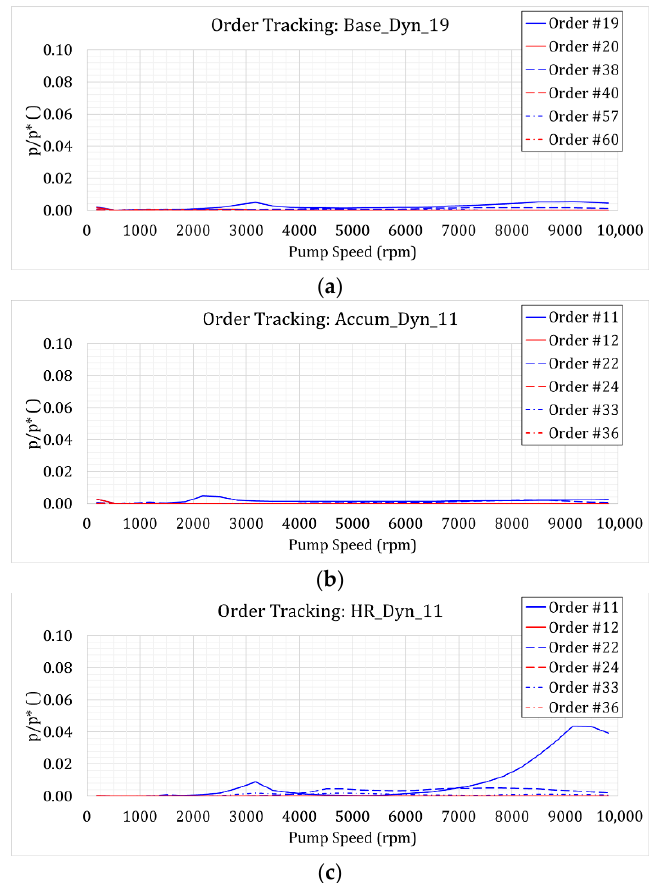
Figure 13. Order tracking graphs of: ( a ) Base_Dyn_19; ( b ) Accum_Dyn_11; ( c ) HR_Dyn_11. Table 6. Resonance pump speeds.